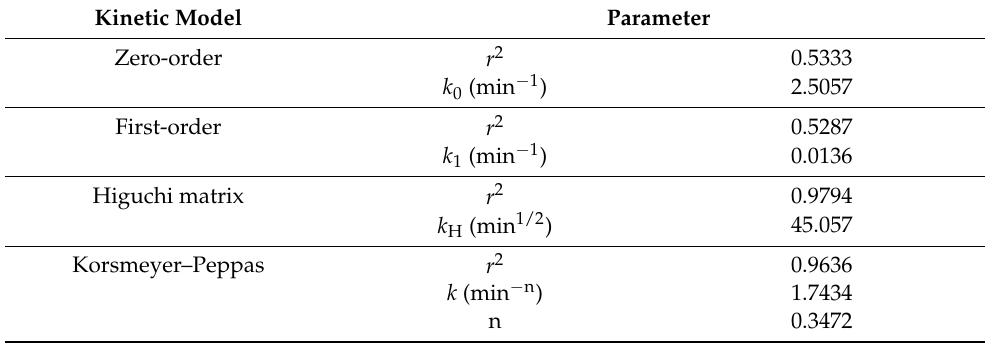
Table 4. Release kinetic data of NCT film using various kinetic